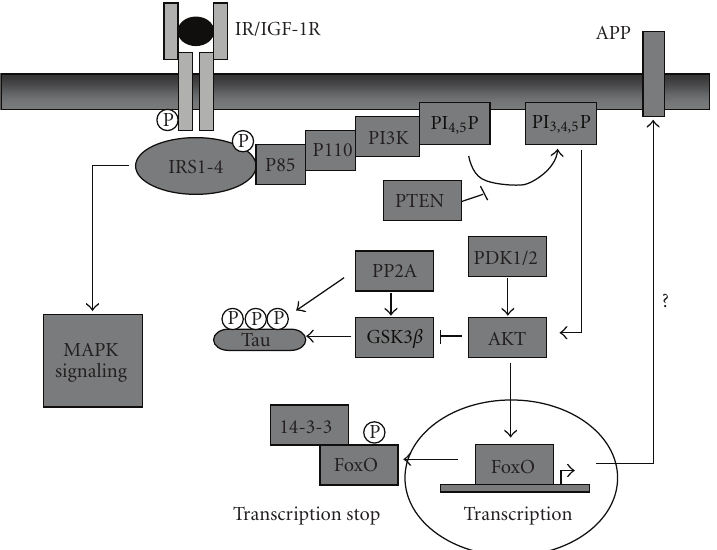
Figure 1: Central IR/IGF-1 signaling. Binding of insulin and IGF-1 to their receptors leads to autophosphorylation of the β -subunits of the IR or IGF-1R, recruitment of IRS-1/-2, and subsequently activation of mainly two pathways the PI3 kinase pathway and the MAP kinase cascade. The PI3 kinase pathway activates Akt which inhibits GSK-3 β . Akt-mediated FoxO1 phosphorylation results in binding of the regulatory protein 14-3-3 and nuclear exclusion of FoxO1. Abbreviations: IR, insulin receptor; IGF-1R, insulin-like growth factor-1 receptor; IRS, insulin receptor substrate; PI3K, PI3 kinase; FoxO1, forkhead-box protein O1; PDK, phosphatidylinositide-dependent kinase; p110/p85, catalytic/regulatory subunit of PI3K; PI 3,4 P, phosphatidylinositide 3,4 -diphosphate; PI 3,4,5 P, phosphatidylinositide 3,4,5-triphosphate; PTEN, phosphatase and tensin homolog deleted on chromosome ten; 14-3-3, regulatory protein 14-3-3; PP2A, protein phosphatase 2A.